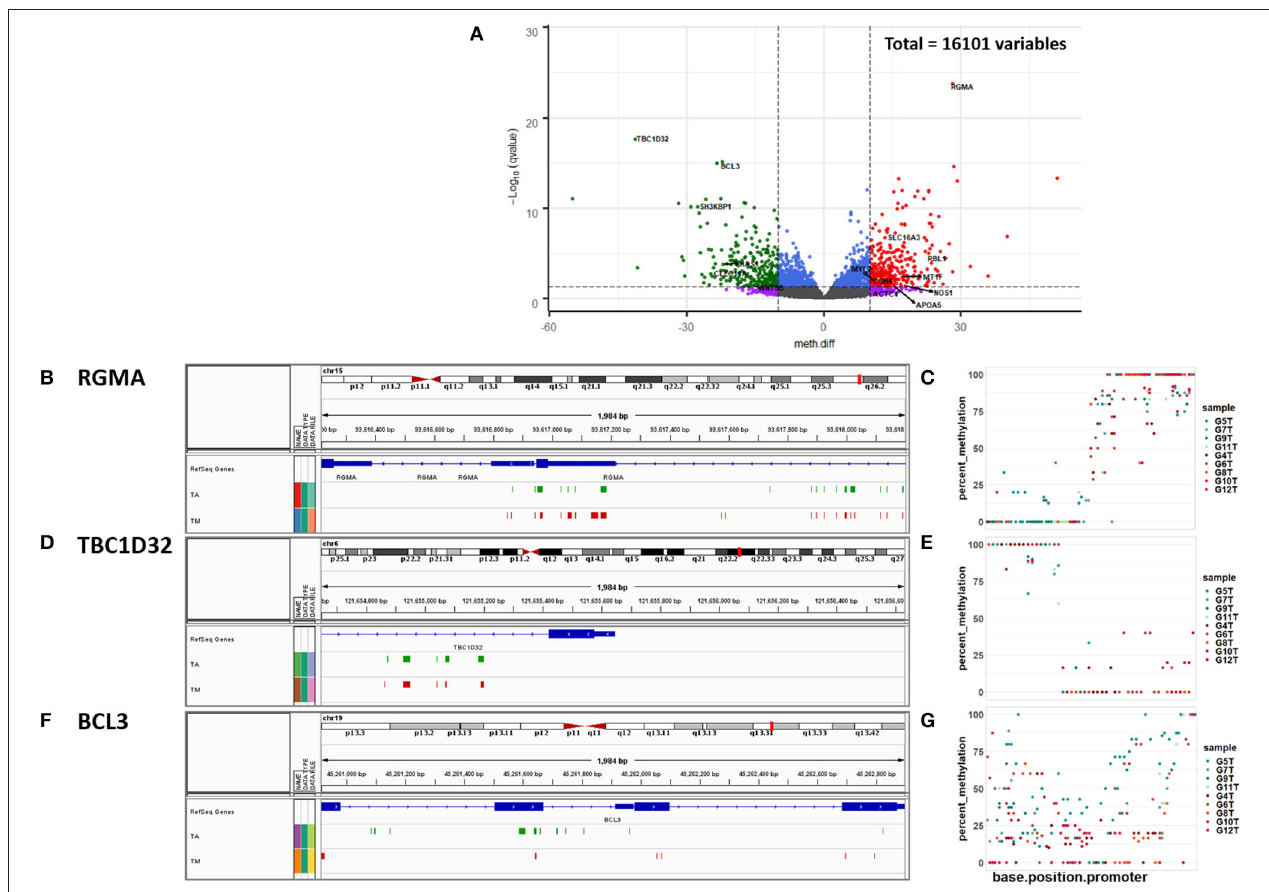
FIGURE 2 | (A) Volcano plot of promoter methylation profiles. The vertical lines x = − 10 and x = 10 represent our chosen methylation difference (meth.diff) cut-off value of |10|. meth.diff is calculated as described in the Methods. The horizontal line [y = -log 10 (0.05) = 1.3] shows our chosen q-value cut-off of 0.05. The circles represent the 16,101 promoters, of which 584 are differentially methylated (DM). Each circle in the volcano plot represents a promoter with its meth.diff and -log 10 (q-value). Gray circles denote promoters that are not DM. Purple circles represent promoters that are biologically, but not statistically significant. Blue circles depict the opposite trend. Red and green circles show promoters that are both statistically and biologically significant. Genes with a meth.diff > 0 (red) show increased methylation in the mitral compared to the aortic valve ( ↑ ) and genes with a meth.diff < 0 (green) show decreased methylation in the mitral compared to the aortic valve ( ↓ ). Snapshots of the IGV genome browser showing the top 3 most significantly differentially methylated promoters linked to (B) RGMA (C) TBC1D32 and (D) BCL3, respectively (coordinates identified in Supplementary Table 1 ). TM denotes the union of the percent methylation values in all mitral samples that are > 70% and which are present in the mitral but not in the aortic samples. TA denotes the union of the percent methylation values in all aortic samples that are > 70% and which are present in the aortic but not in the mitral samples. Scatter plots of the percent methylation per base per promoter of the top 3 most significantly differentially methylated promoters linked to (E) RGMA (F) TBC1D32 and (G) BCL3, respectively (coordinates identified in Supplementary Table 1 ). Aortic samples: G5T, G7T, G9T, G11T; mitral samples (G4T, G6T, G8T, G10T,